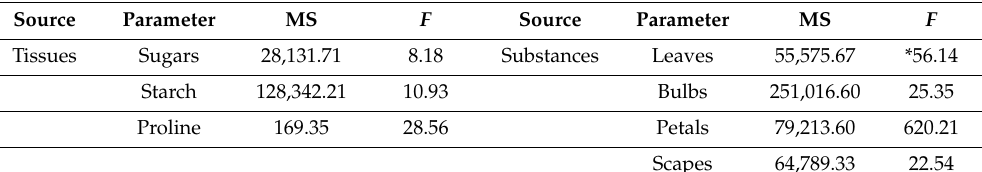
Figure 3. Proline content in bulbs (brown bars), expanded leaves (green bars), scapes (dashed bars), and petals (white bars) of Pancratium maritimum, from January (I) to December (XII). Each column denotes means of five replicates ± Standard Error; Standard Errors smaller than the line thickness of the columns are not shown. Significant di ff erences ( p ≤ 0.05) of mean values are presented by di ff erent lowercase letters (a–f) on bars. Table 2. A two-way analysis of variance (ANOVA) was performed on ecophysiological traits among di ff erent tissues; statistically significant di ff erences at * p <